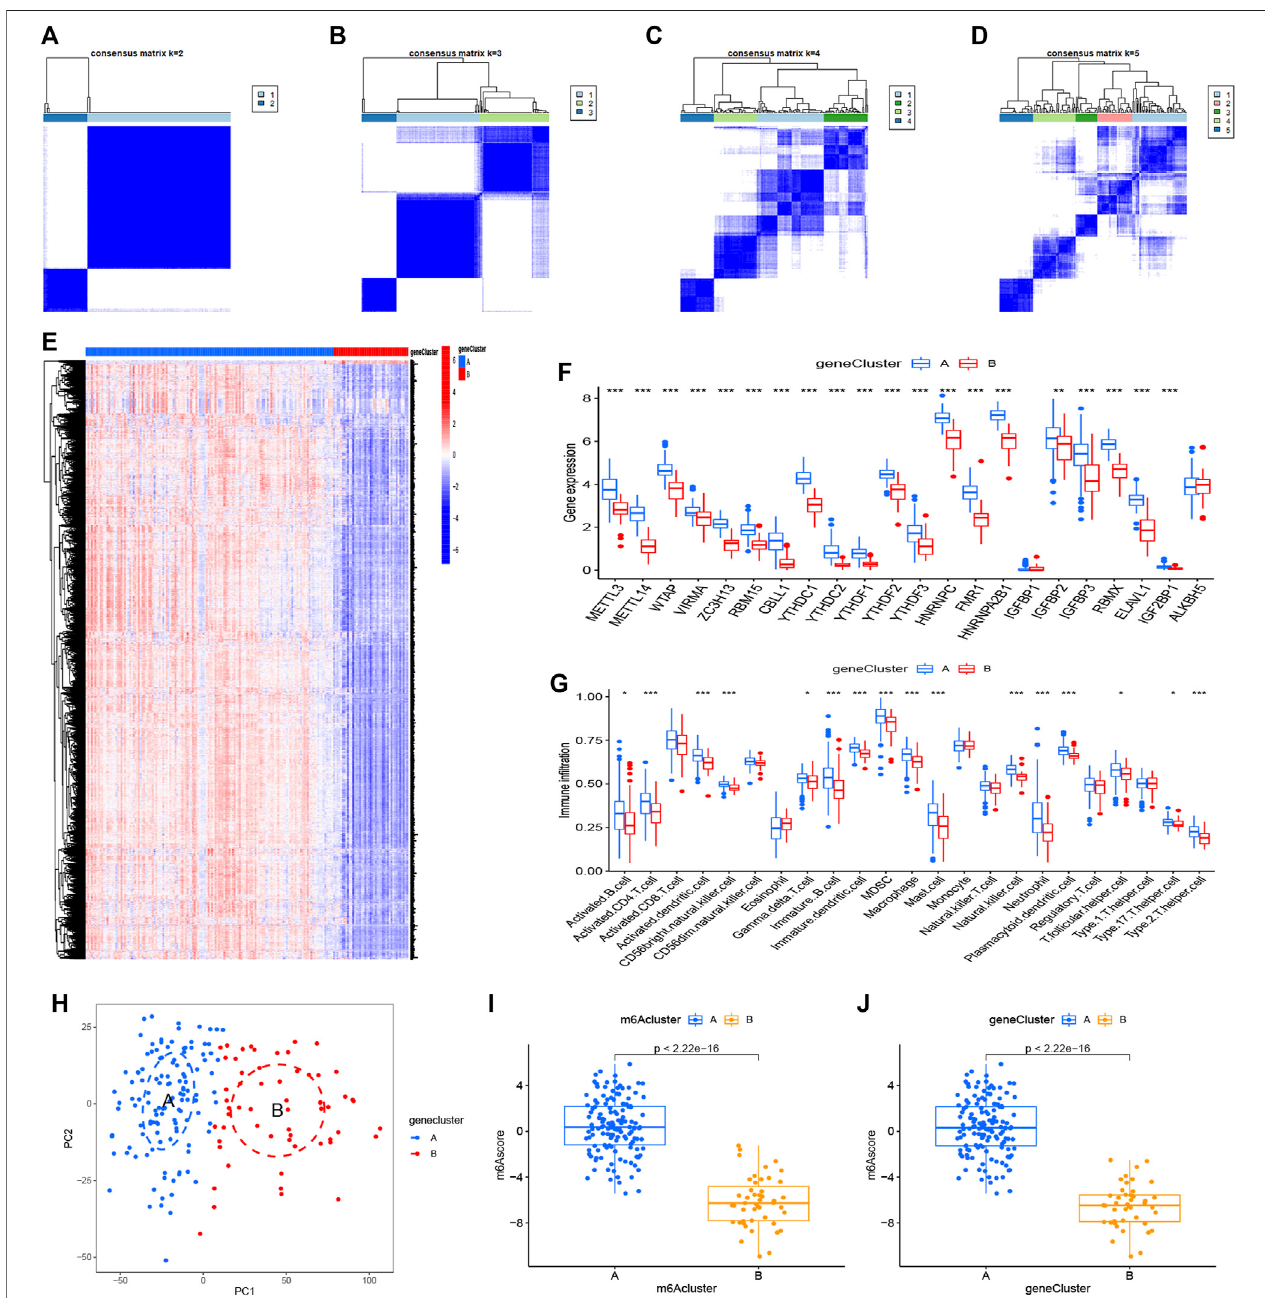
FIGURE 7 | Consensus clustering of the 3,168 m6A-related DEGs (A – D) Consensus matrices of the DGEs (k = 2 – 5) (E,F) Expression heatmap and histogram of the 3,168 m6A-related DEGs in gene cluster A and gene cluster B (G) The differential immune cell in fi ltration of DEGs in the two gene patterns (H) Principal component analysis for the expression pro fi les of gene subtypes, also shows a remarkable difference between different modi fi cation patterns. (I,J) Differences in m6A score based on PCA algorithm between the two m6A patterns or the two gene patterns. * p < 0.05, ** p < 0.01, and *** p < 0.001.